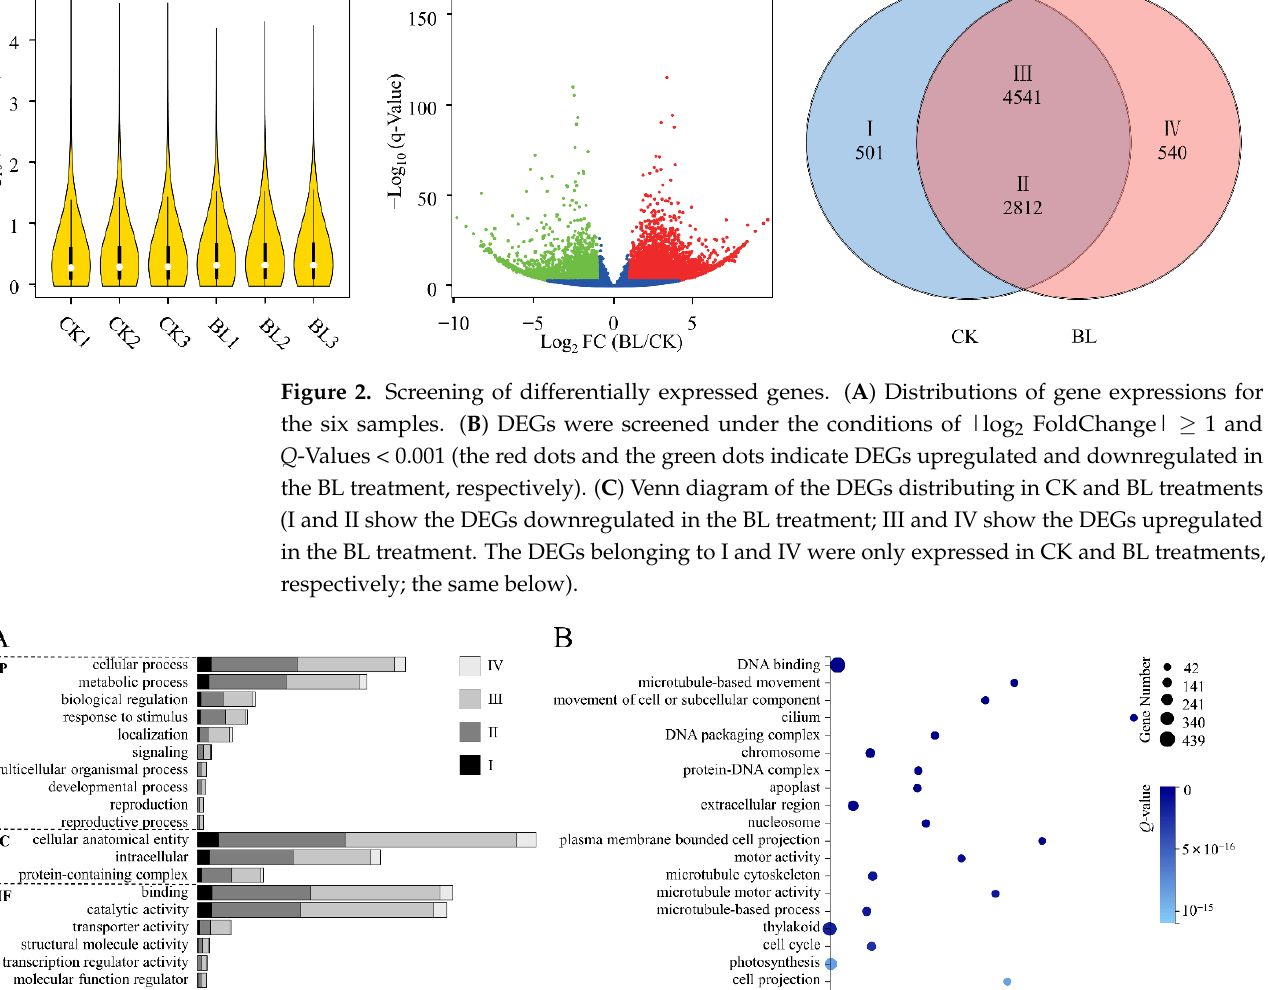
Figure 2. Screening of differentially expressed genes. ( A ) Distributions of gene expressions for the six samples. ( B ) DEGs were screened under the conditions of |log 2 FoldChange| ≥ 1 and Q- Values < 0.001 (the red dots and the green dots indicate DEGs upregulated and downregulated in the BL treatment, respectively). ( C ) Venn diagram of the DEGs distributing in CK and BL treatments (I and II show the DEGs downregulated in the BL treatment; III and IV show the DEGs upregulated in the BL treatment. The DEGs belonging to I and IV were only expressed in CK and BL treatments, re- spectively; the same below).